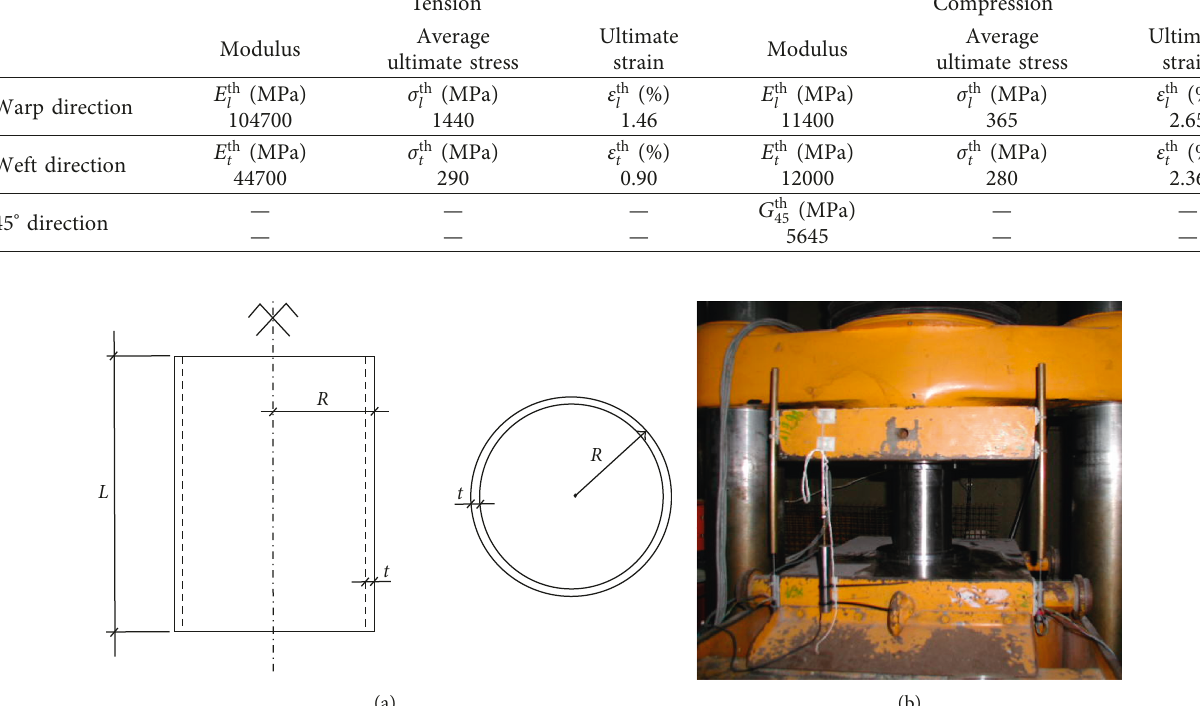
Figure 3: (a) Geometry characteristics of specimens tested; (b) boundary conditions (simply supported).